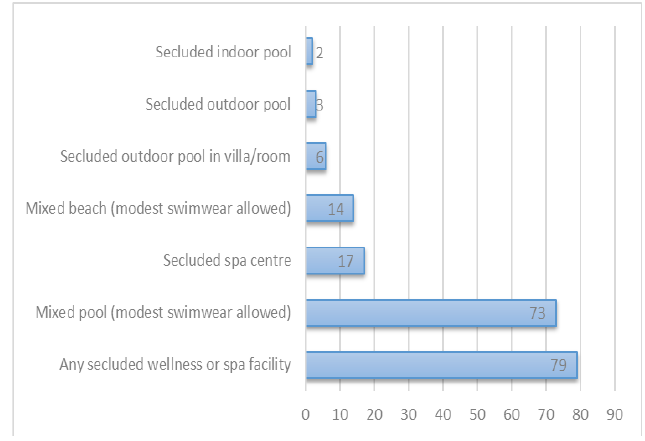
Figure 2. Leisure activities for ladies and